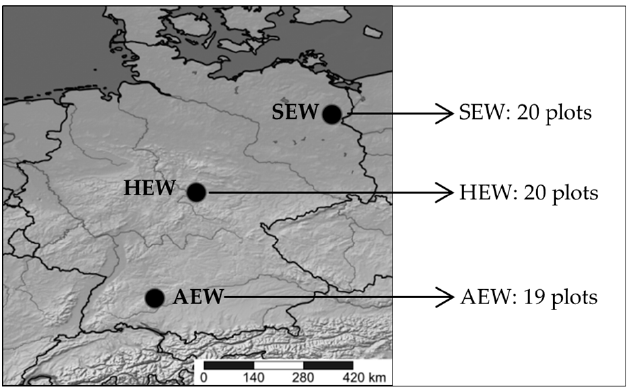
Figure 1. Map of the three study regions in Germany with information on the number of plots within regions. The map was created with SimpleMappr [43].